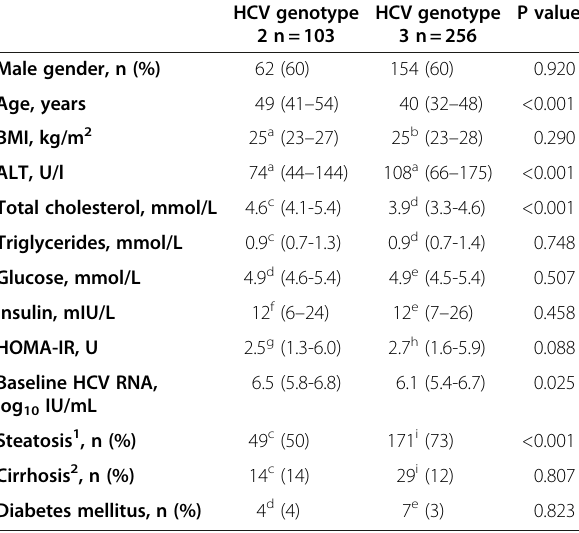
Table 1 Baseline characteristics stratified by